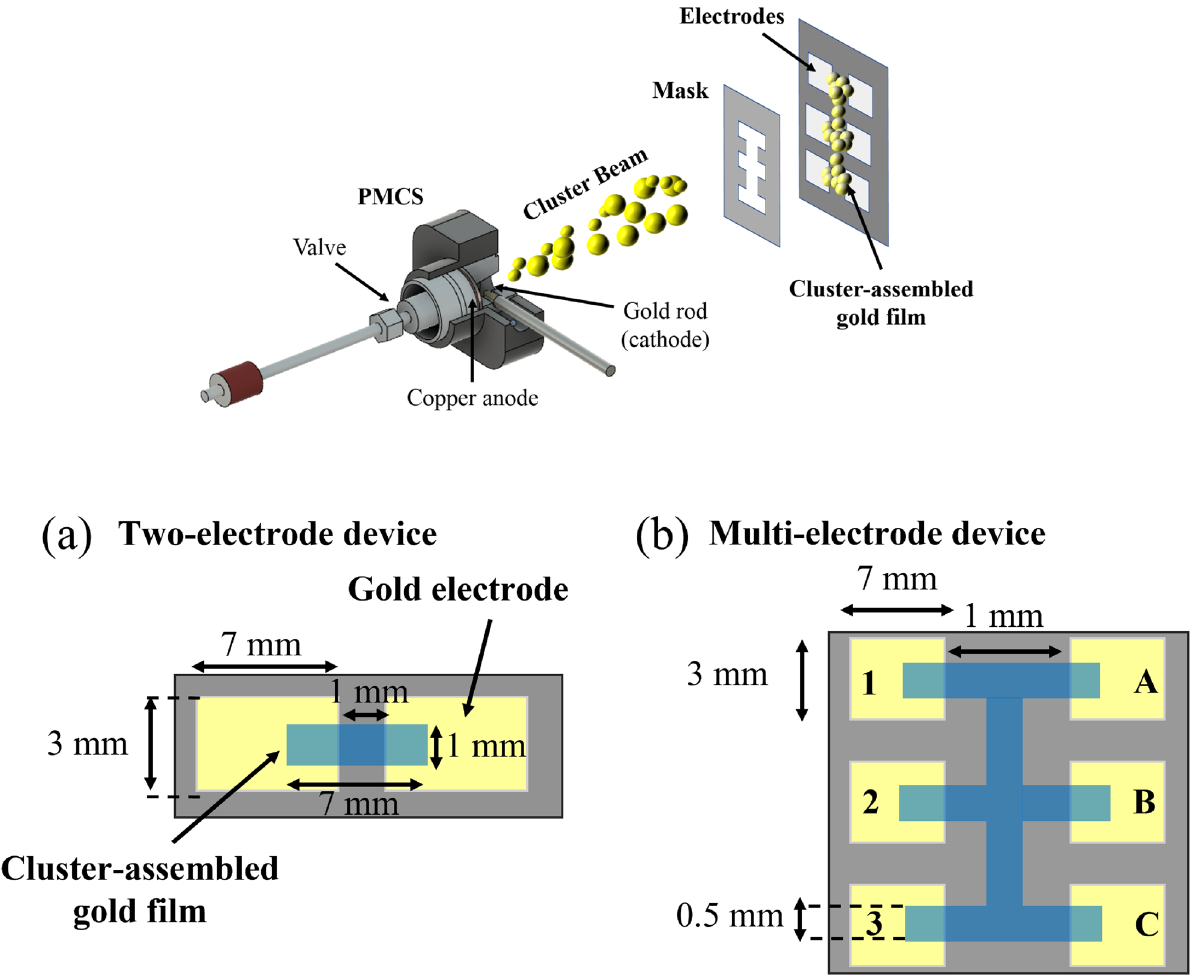
Figure 7. In the top panel the deposition process is depicted: the stencil masking allows the patterning of cluster assembled film via the interception of the cluster beam. In the bottom one two types of devices and their dimensions are depicted: ( a ) Two-electrode device, consisting of a couple of gold electrodes bridged by a cluster assembled Au film; ( b ) Multi-electrode device consisting of one vertical and three horizontal cluster-assembled film stripes linking the six